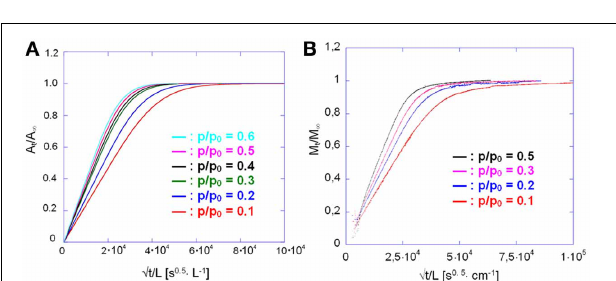
Figure 13 | Sorption kinetics of methanol in PMDA-ODA at different relative pressures, as indicated. (A) Spectroscopic measurements; (B) gravimetric